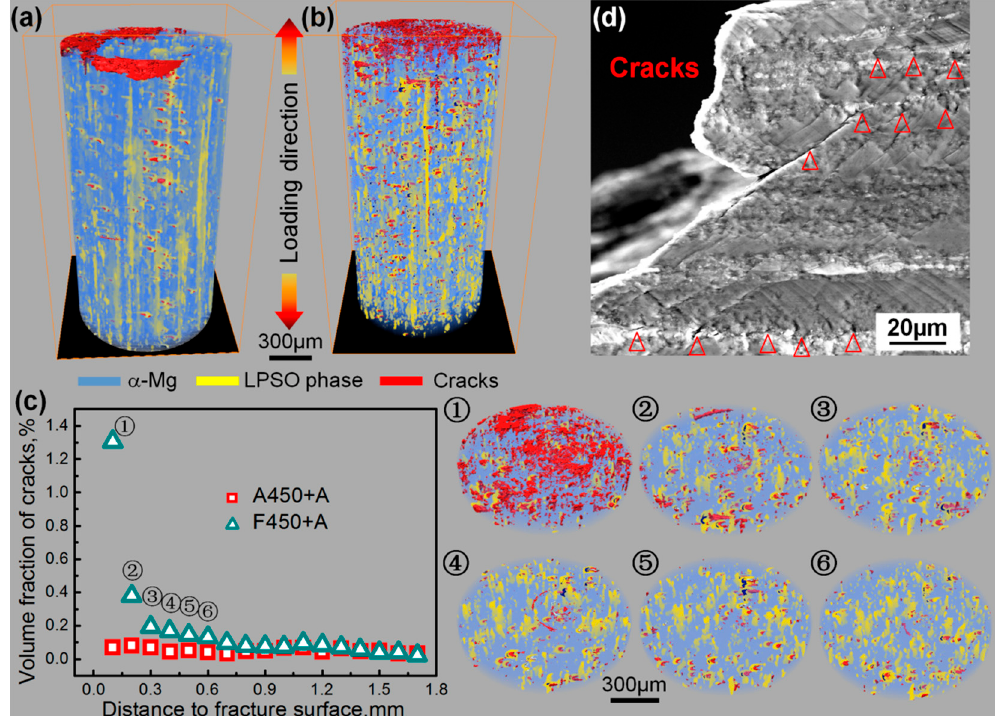
Figure 11. Microstructure of the fractured tensile samples [13]. 3D distributions of the cracks and LPSO phases in the fractured ( a ) A450+A and ( b ) F450+A samples using SR- μ CT. ( c ) Curves of crack volume fractions plotted as a function of distance to the fracture surface of two fractured samples. The slices obtained from the F450+A sample for calculation are numbered 1–6 and shown on the right side. ( d ) SEM image taken from the F450+A sample adjacent to the fracture surface and the cracks are indicated by red arrowheads.